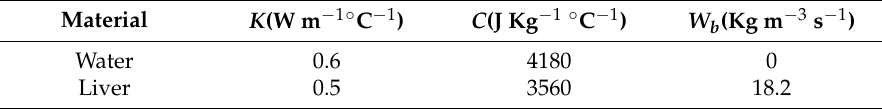
Table 2. Values of thermal parameters in this study (37 ◦ C).